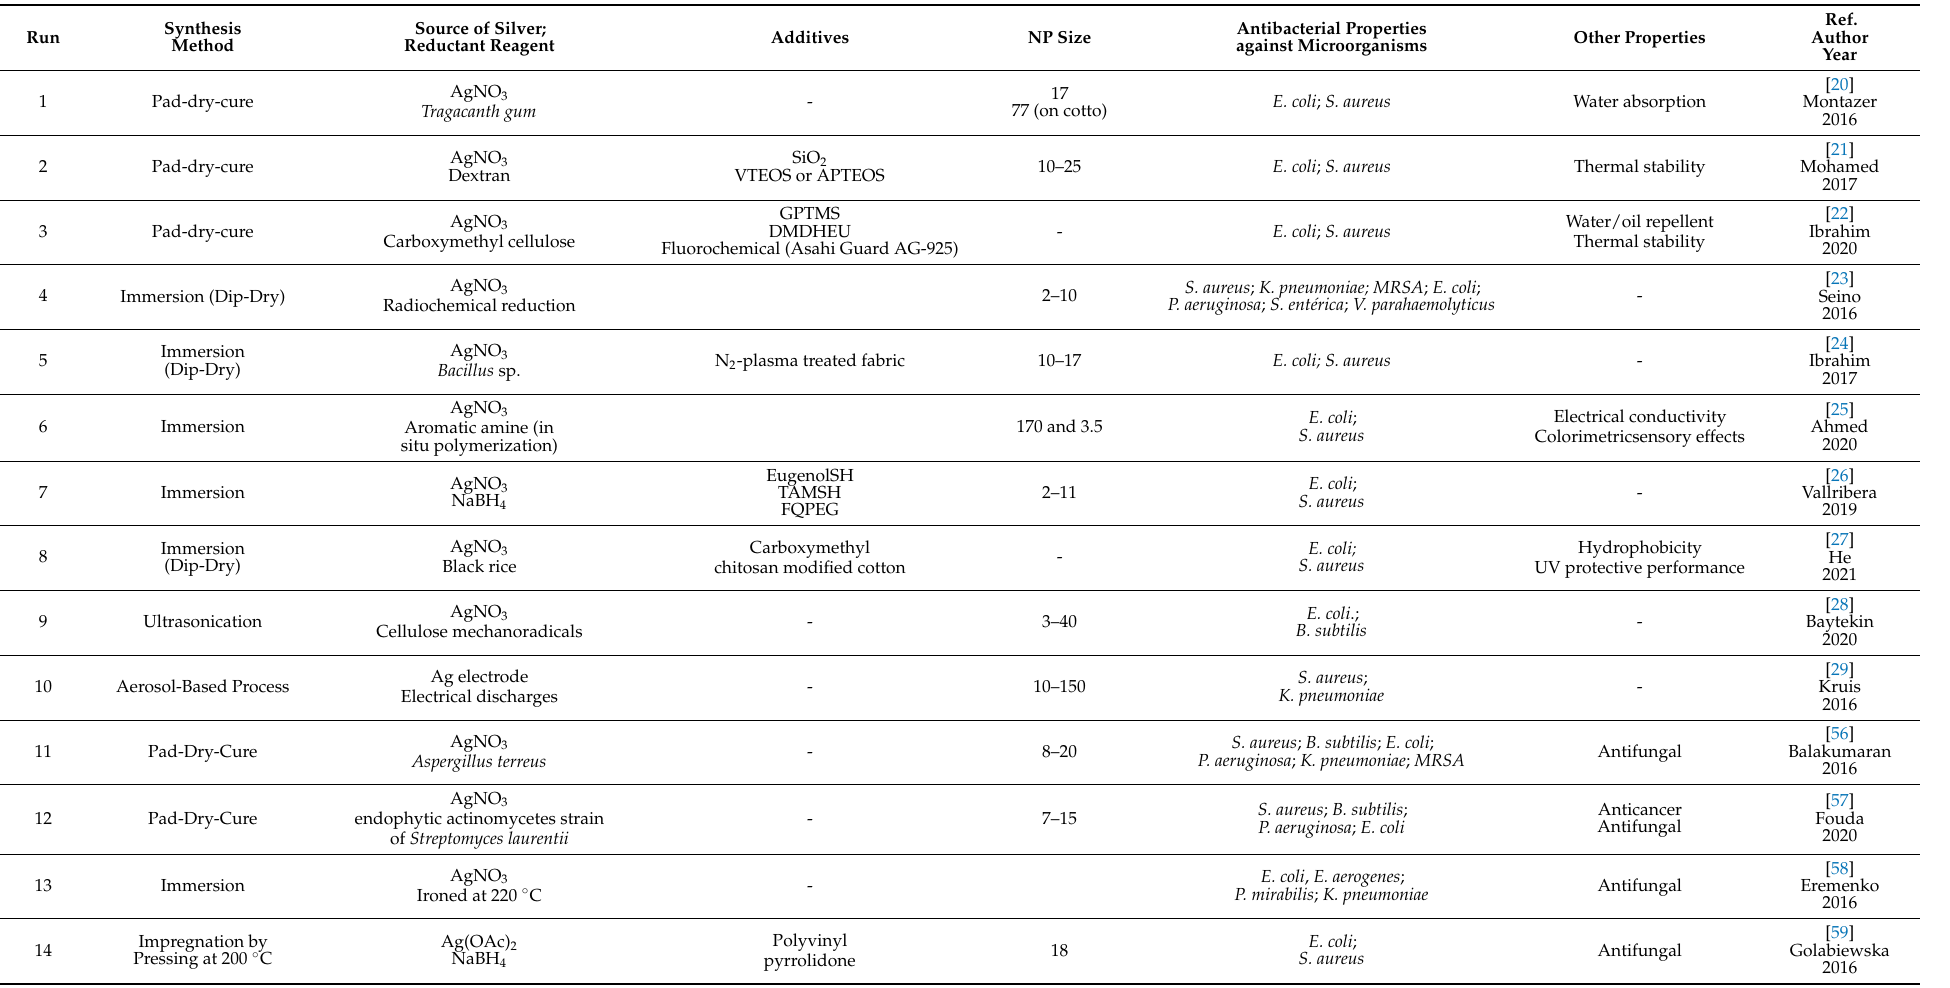
Table 1. Summary of Ag NPs-coated textiles and its bacterial effect